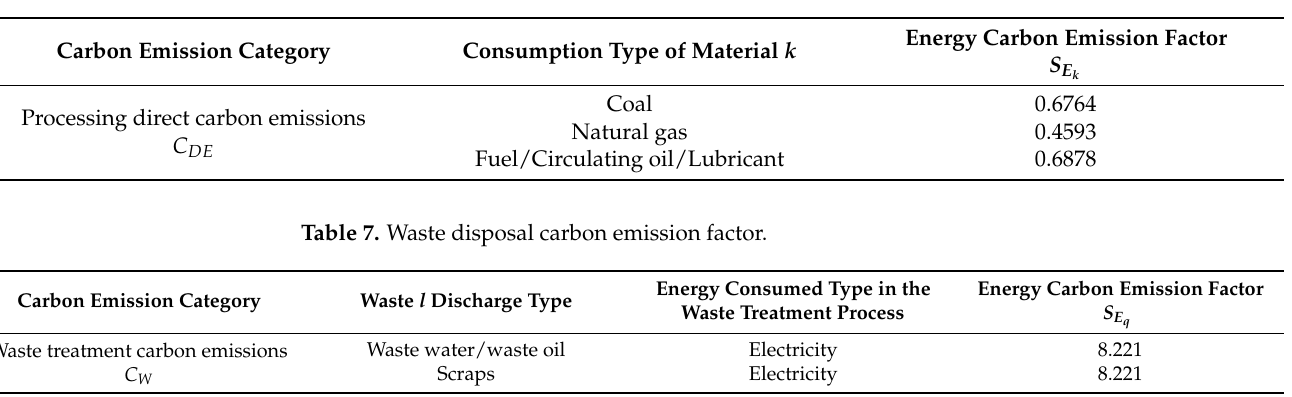
Table 6. Direct carbon emission factor from fossil energy.